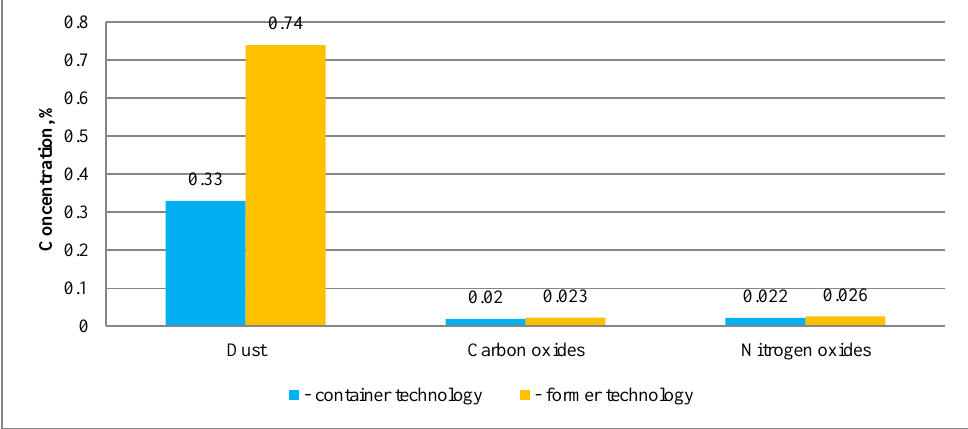
Fig. 3. Reduction of harms in the atmosphere of an open-pit mine as a result of introduction of a container